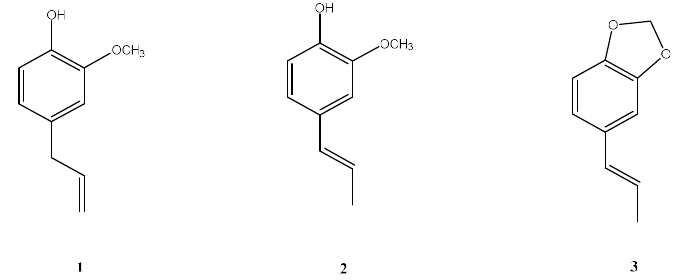
Figure 1. Chemical structure of eugenol ( 1 ), isoeugenol ( 2 ) and safrole ( 3 ).